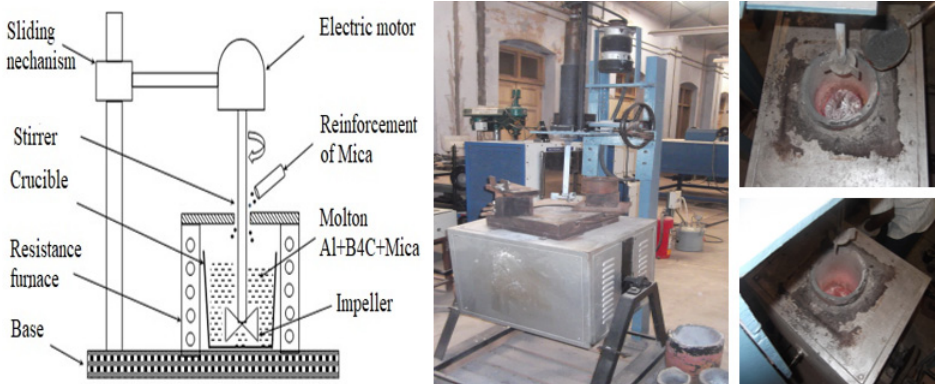
Figure 1. Stir casting setup used. Table 1. Material properties of the composite materials [25].